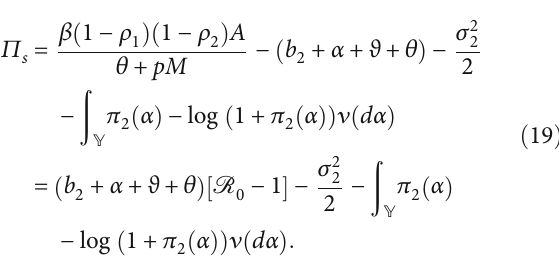
ð α Þ = 0 : 1 , π ð α Þ = 0 : 04 , π 2 3